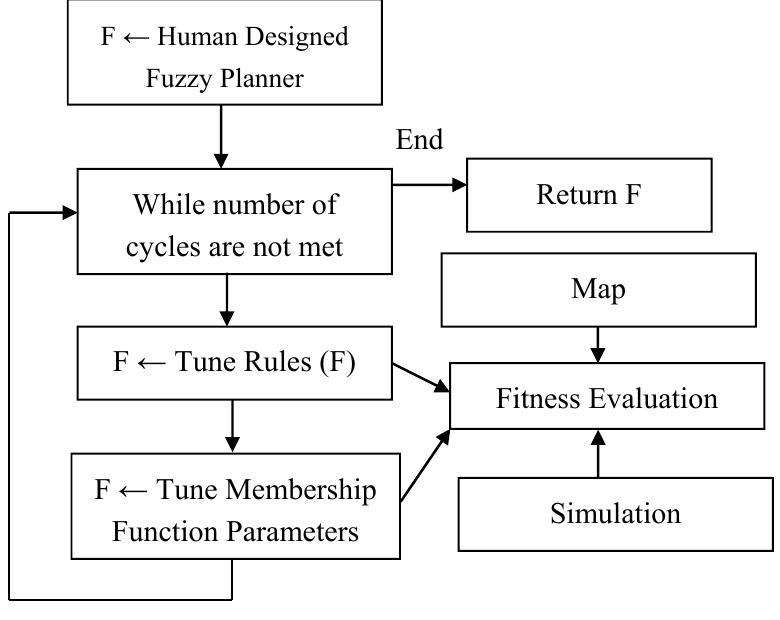
Figure 9. Evolution of the fuzzy